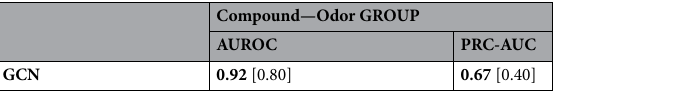
Table 4. Performance of the GCN model applied on the compound-odor dataset grouped on 23 categories. The results in bold are the performance on the full dataset. The value in brackets depicts the results of the fivefold cross validation model.